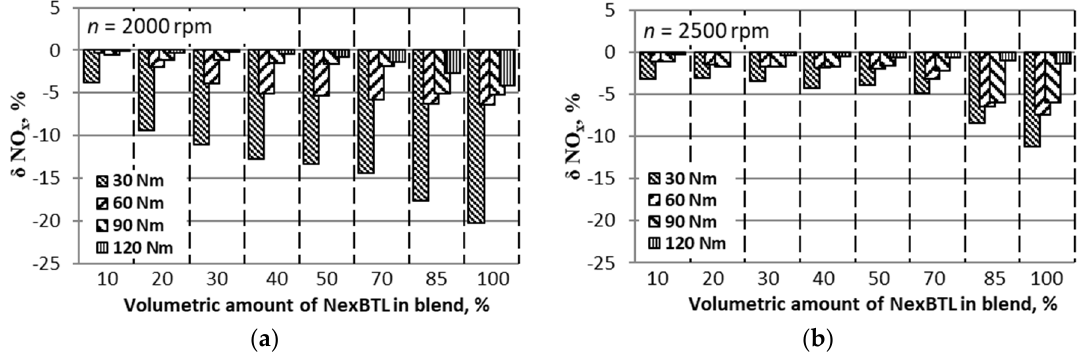
Figure 11. Relative deviation of NO x : ( a ) n = 2000 rpm; ( b ) n = 2500 rpm.